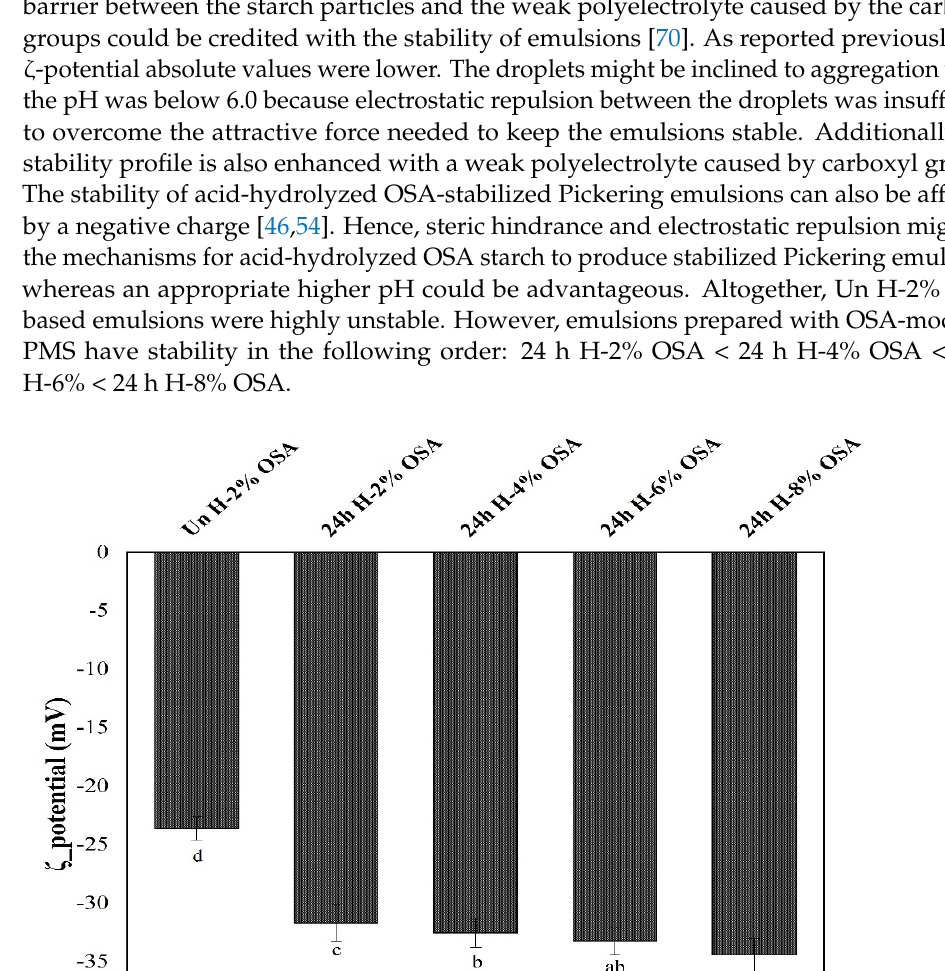
Figure 8. ζ -potential of the five emulsions at pH 4.0, 6.0, and 8.0. A significant difference ( p < 0.05) is indicated in different samples designated with different capital letters (A, B, C, D) while compar- ing for the same pH. Meanwhile, a significant difference ( p < 0.05) is shown in samples designated with a different lower-case letter (a, b, c) while comparing between same samples at different pH. 3.8. Retention Degree and Microencapsulation Efficiency (MEE) of Puerarin